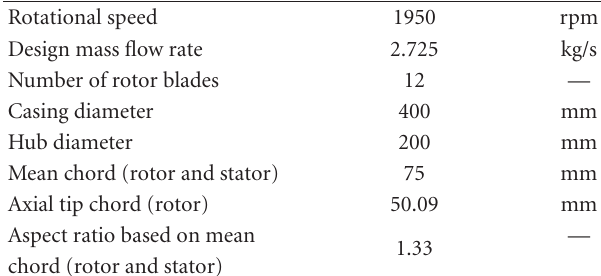
Table 2: Specification of the compressor